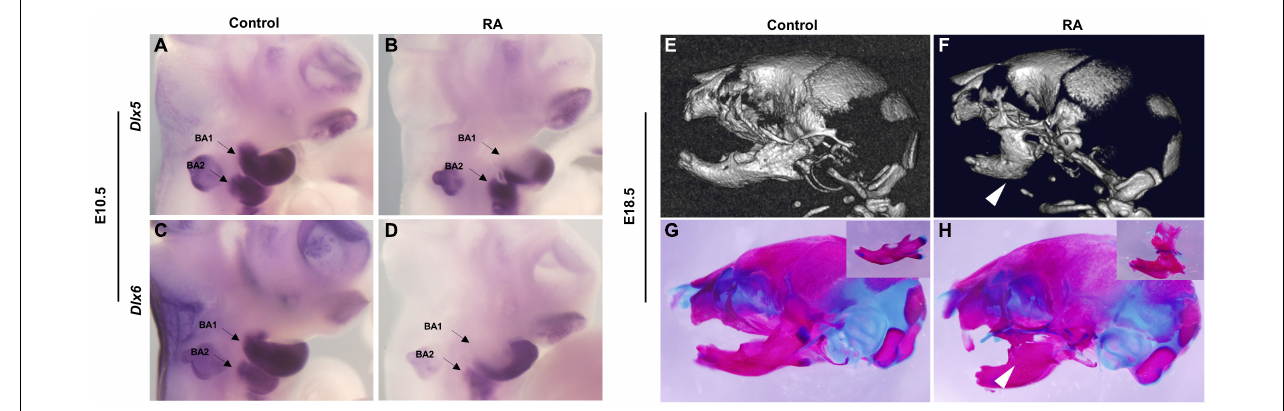
FIGURE 4 | Abnormalities of BA1-derived jaws and associated Dlx5 and Dlx6 expression defects in RA-treated embryos. Lateral views of whole-mount in situ hybridization for Dlx5 (A,B) and Dlx6 (C,D) in E10.5 BA1 and BA2 of control (A,C) and RA-treated (B,D) embryos. (B,D) The expression of Dlx5 and Dlx6 in BA1 is lost in proximal but not in distal regions of RA-treated embryos at E10.5. In BA2, the expression of Dlx5 and Dlx6 is not affected in E10.5 RA-treated embryos. Arrows denote BA1 and BA2 hybridization signal or absence of signal. Micro-CT scans (E,F) and Alizarin red (bone) and Alcian blue (cartilage) stained skeletal preparations (G,H) of E18.5 control (E,G) and RA- treated (F,H) embryos. The white arrowheads in (F,H) mark the syngnathia in RA- treated embryos. Higher magnifications of dissected jaws are shown in the boxes of (G,H)